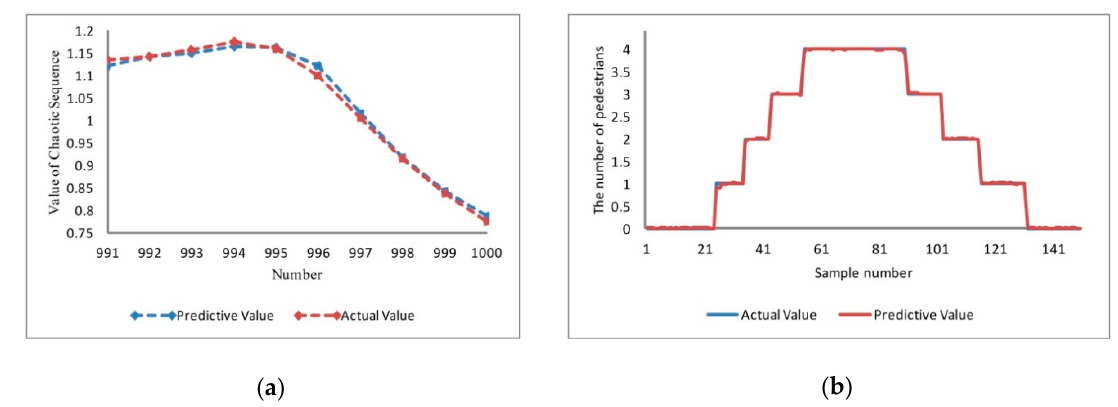
Figure 8. ( a ) Comparison of the actual value and the predicted value from Number 991 to Number 1000; ( b ) comparison of actual and predicted numbers of pedestrians in the video.